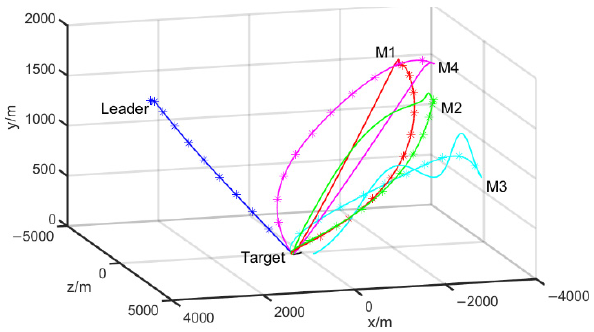
Figure 8. Flight trajectory curve of the cooperative attack on target 2.